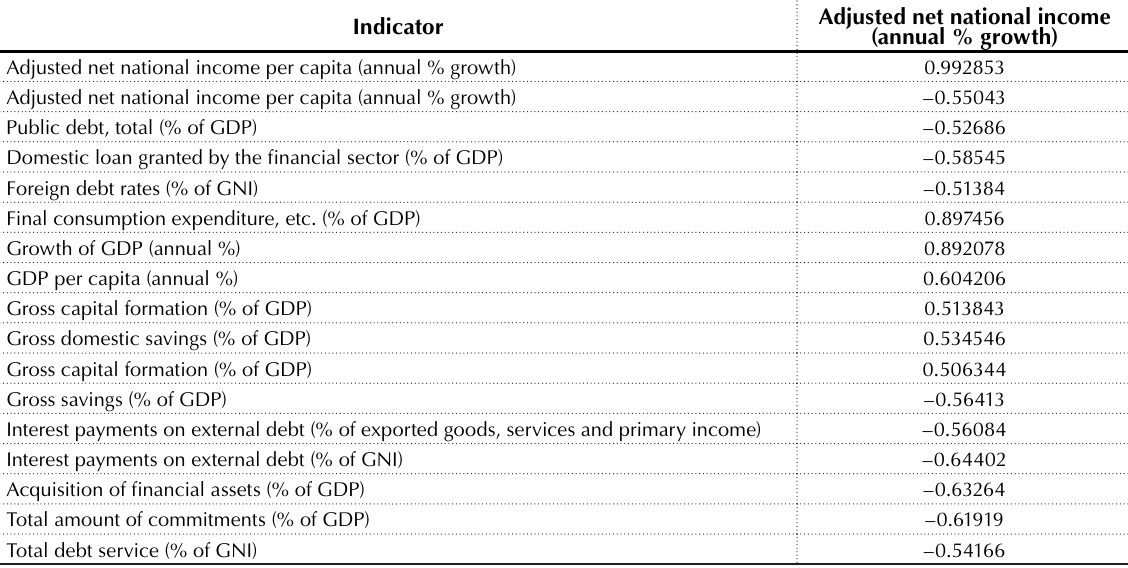
Table 2. Correlation coefficients of the impact estimation of the national economy indicators of Ukraine on the adjusted net national